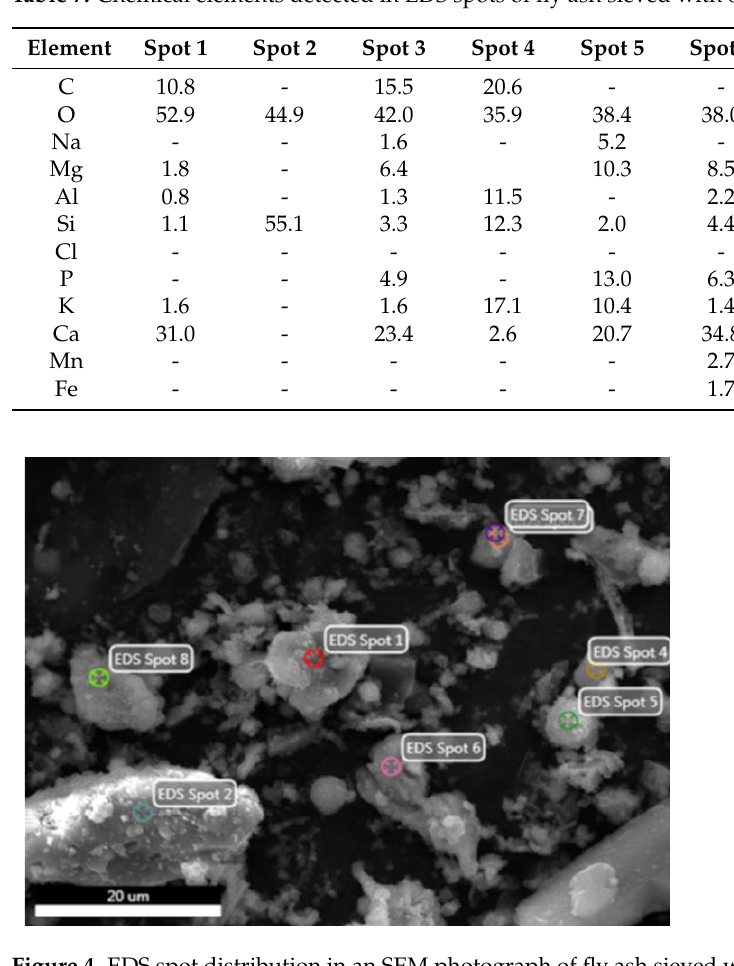
Figure 4. EDS spot distribution in an SEM photograph of fly ash sieved with 63 µm. As shown in Tables 5 and 6, sieving influenced both the chemical composition and physical properties of the investigated wood biomass fly ash. FA(B)63 and FA(B)125 fly ash had higher amounts of CaO and smaller amounts of SiO 2 than untreated FA(B)N fly ash. CaO was observed in the form of lime and portlandite (Figure 1). These minerals, together with arcanite, were mostly responsible for the hydraulic reactivity of biomass fly ash